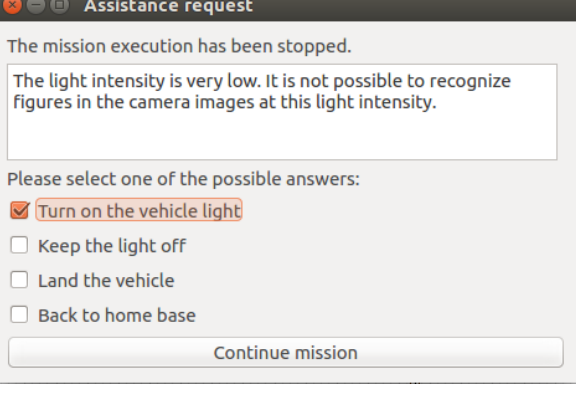
Figure 12. Example of window to request assistance.